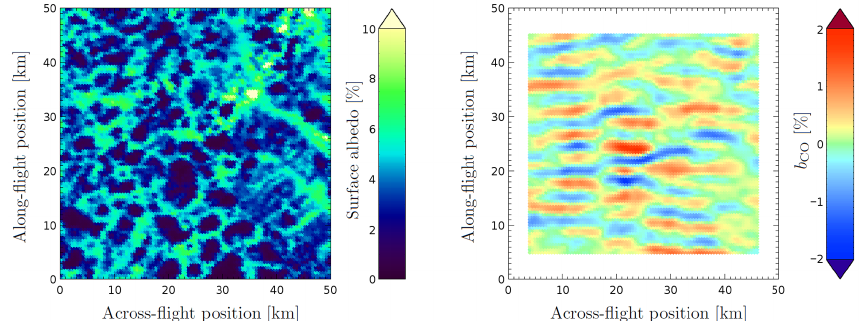
Figure 11. Error due to heterogeneous slit illumination by a scene with varying surface reflection over a marsh scene in Siberia close to the river Ob at latitude 62.8 ◦ N and longitude 72.1 ◦ E. Left panel: MODIS Lambertian albedo at 2.1µm with a spatial sampling of 0 . 5 × 0 . 5km 2 . Right panel: CO retrieval error due to heterogeneous illumination of the instrument entrance